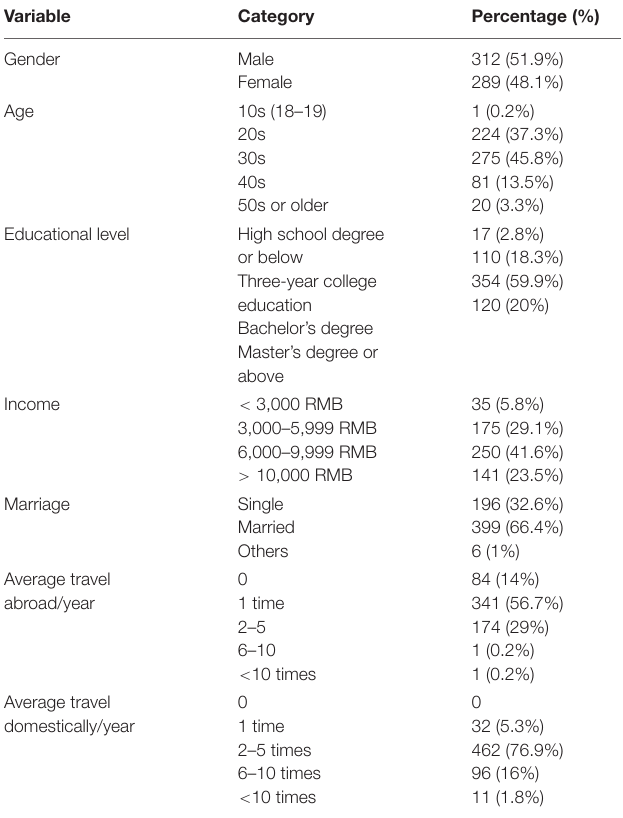
TABLE 1 | Profiles of the respondents ( N =